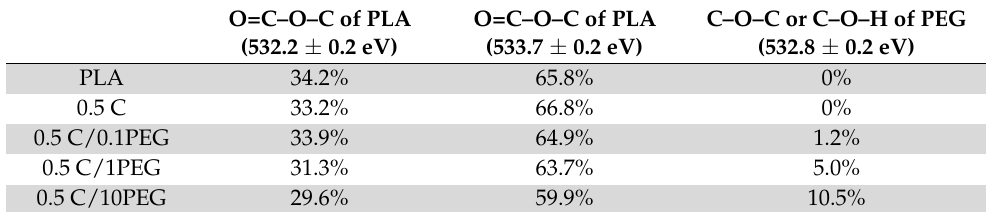
Table 3. Area ratios of characteristic peaks in O 1s spectra.